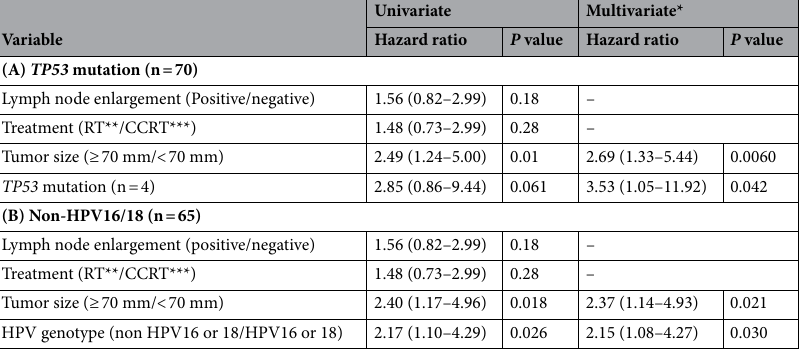
Table 3. Correlation between TP53 mutation or HPV genotypes and progression-free survival in locally advanced cervical cancer patients. *Stepwise multiple regression analysis, **Radiation therapy, ***Concurrent